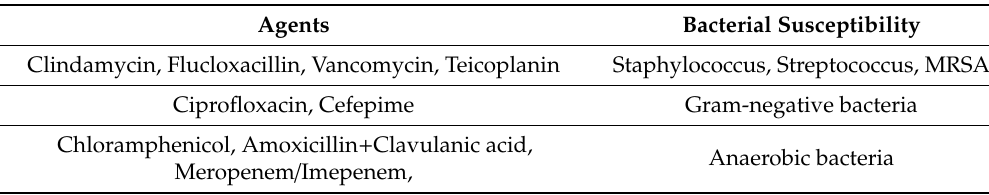
Table 2. Antibiotics for initial and empirical